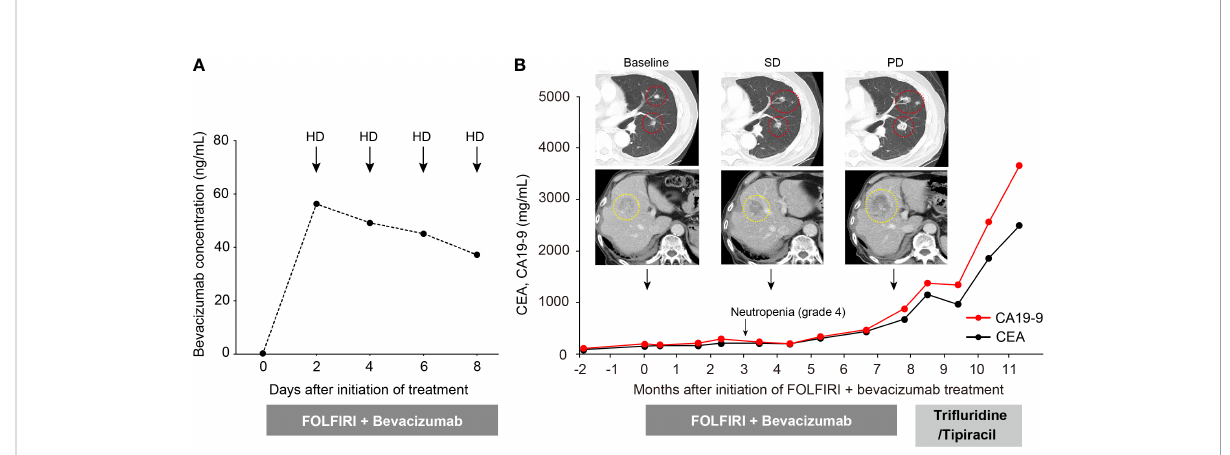
FIGURE 1 Changes in serum bevacizumab concentration and clinical course of the patient. (A) Changes in serum bevacizumab concentration at fi ve time points after treatment initiation. (B) Clinical course of the patient. Red and yellow circles represent lung and liver metastases, respectively.